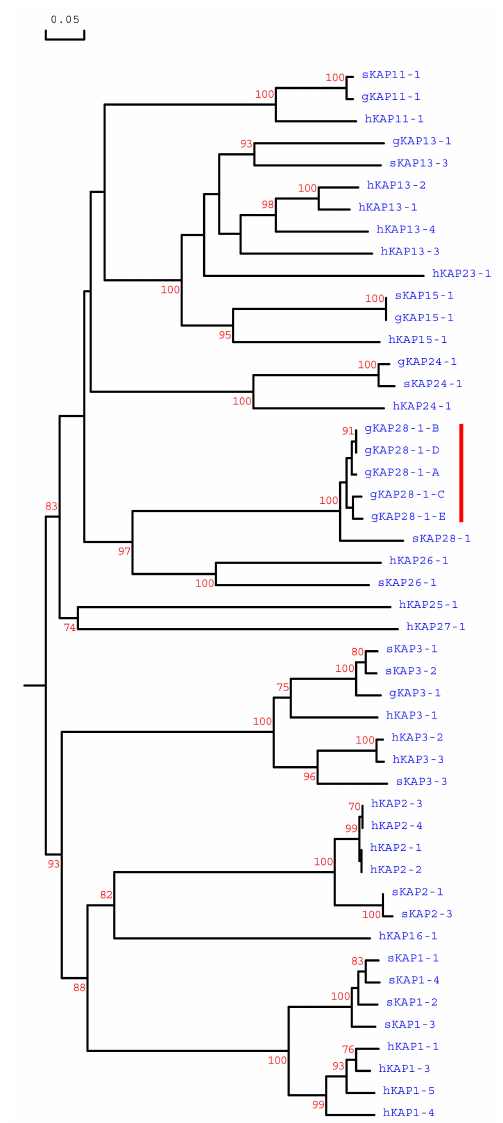
Figure 3. Maximum parsimony tree of the high sulphur KAPs identified in goats, sheep and humans. The tree was constructed using the amino acid sequences (or predicted amino acid sequences). The numbers at the forks indicate the bootstrap confidence values, and only those equal to, or higher than 70%, are shown. The caprine, sheep and human KAPs are indicated with a prefix “g”, ‘s” and “h”, respectively. The five newly identified goat KAP28-1 sequences are indicated with a red vertical line, and the GenBank / EMBL accession numbers for other HS-KAPs are: